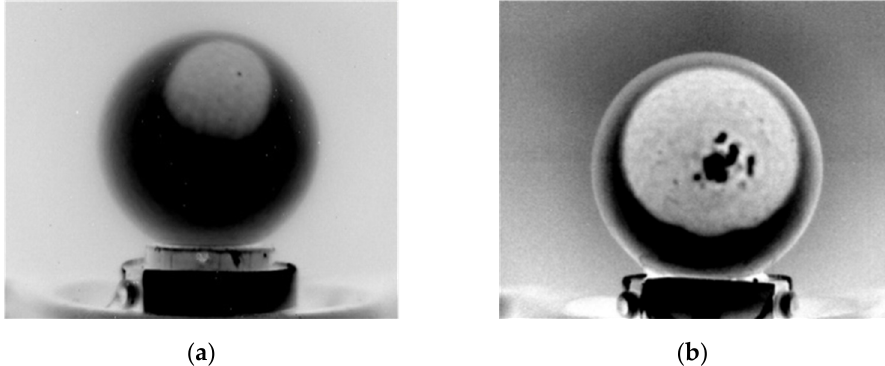
Figure 10. Causes of errors in air chamber sizing: ( a ) reflections on eggshell and ( b ) holes in the air chamber (defects of the egg shell).